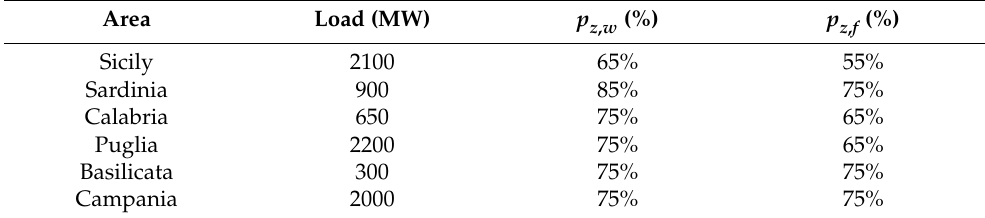
Table 6. Assumptions regarding load value and RES technologies’ producibility values for all areas under